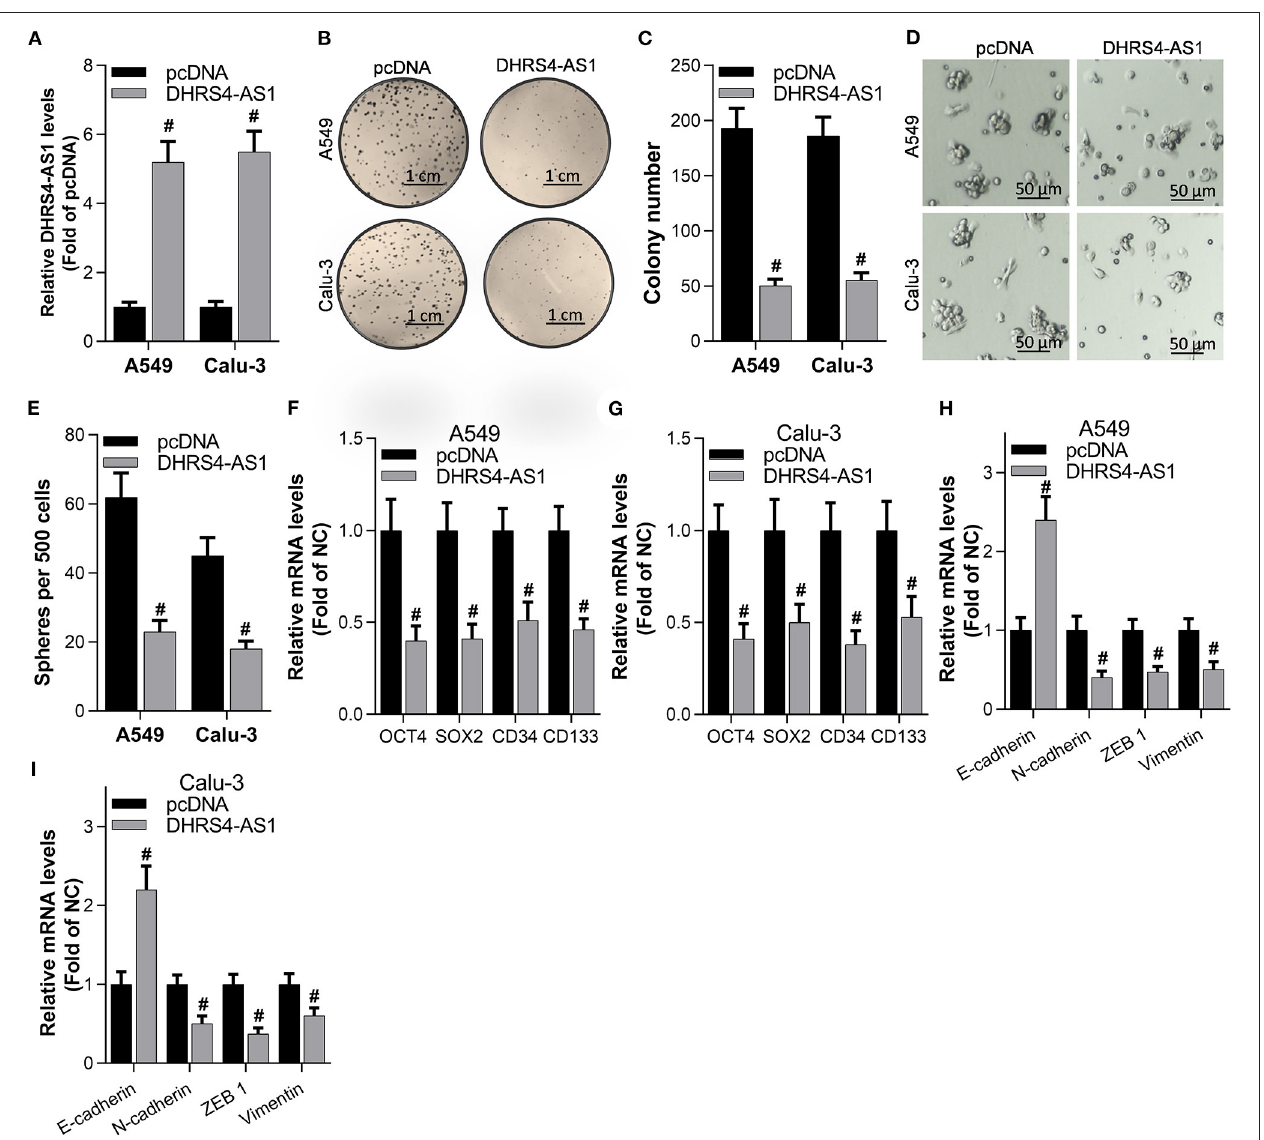
FIGURE 2 | DHRS4-AS1 suppressed colony formation and stem cell-like properties in vitro . (A) Real-time PCR analysis of DHRS4-AS1 expression after 48h of transfection in A549 and Calu-3 cancer stem cells; # p < 0.01 vs. pcDNA. (B,C) Colony formation analysis of A549- and Calu-3-derived stem cells after overexpressing DHRS4-AS1 for 10 days, at which point the colonies were captured and counted; # p < 0.01 vs. pcDNA. (D,E) Representative images of spheres formed by cancer stem cells (D) and quantification of cancer stem cell spheres; # p < 0.01 vs. pcDNA. (F,G) Real-time PCR analysis of the expression of cancer stemness-related genes after 72h of transfection in A549 and Calu-3 cancer stem cells; # p < 0.01 vs. pcDNA. (H,I) Real-time PCR analysis of the expression of EMT-related factors in tumor spheres; # p < 0.01 vs. pcDNA. All the results are expressed as the mean ± SD from three independent experiments, and each sample was repeated in triplicate.